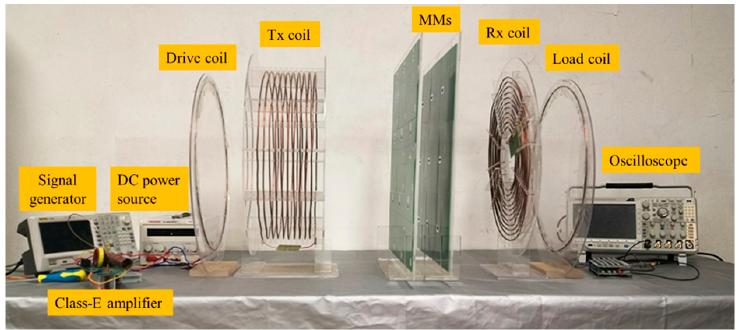
Figure 7. Experimental setup of four-coil WPT system with MM slabs.